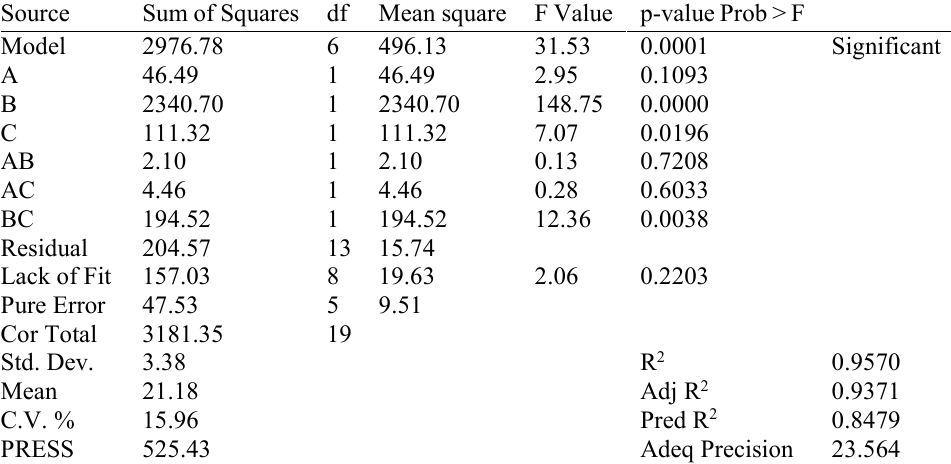
Table 7. Linear model of ANOVA for TDS removal efficiency in ED process